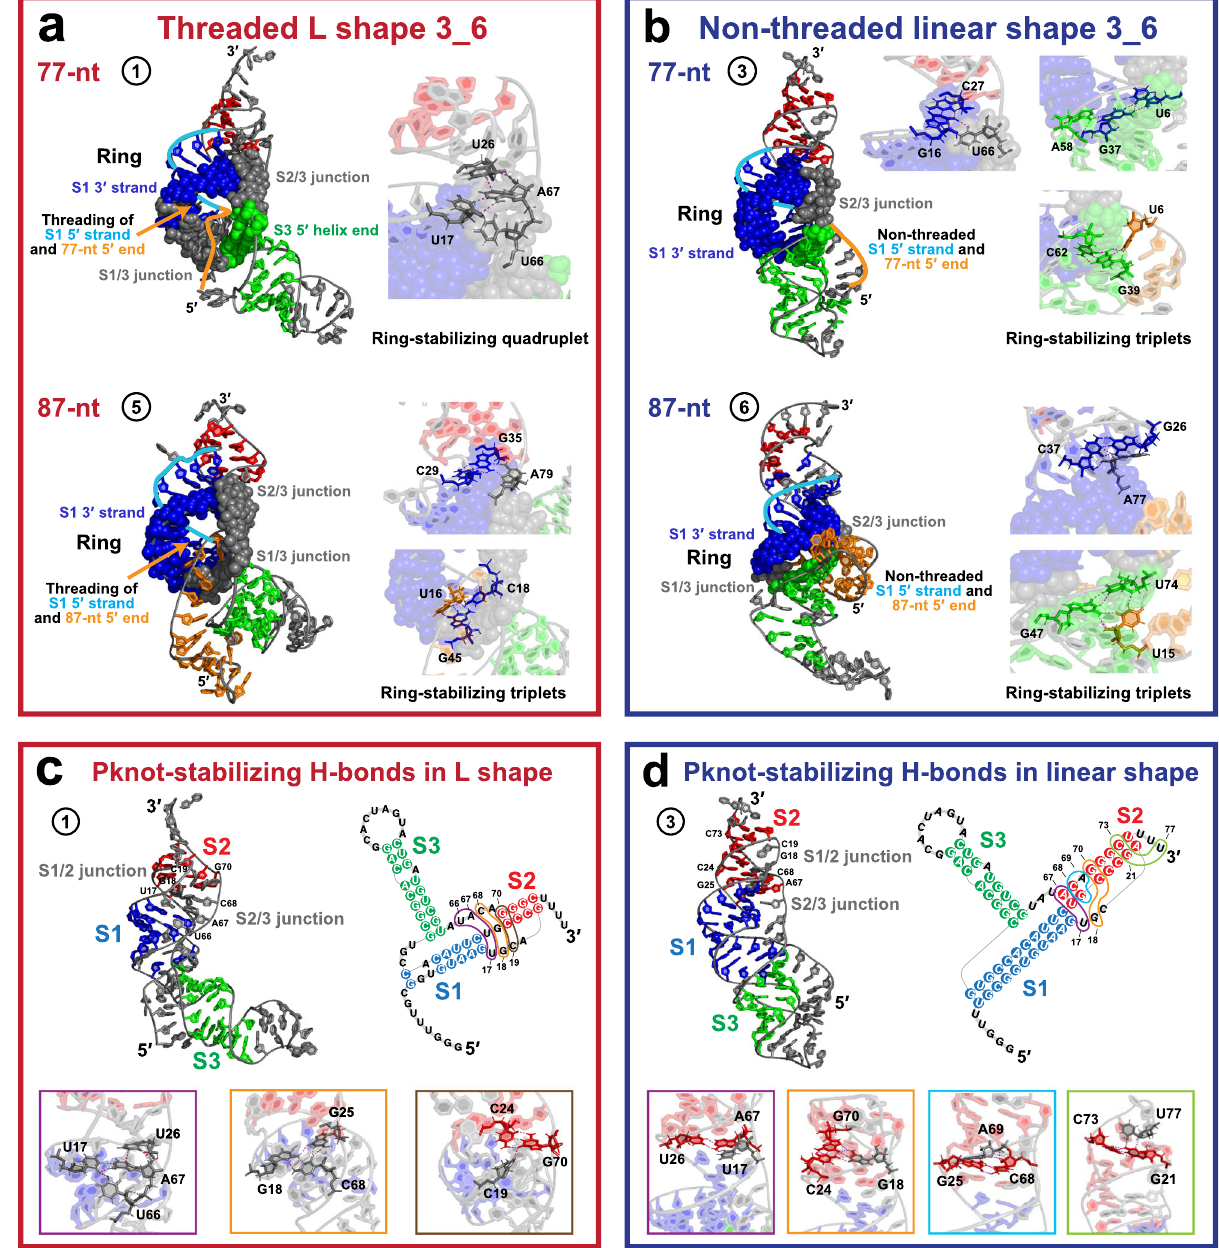
Fig. 3 Threaded L and non-threaded linear 3_6 pseudoknot ring conformations. a The threaded 3_6 models have a ring formed by the 3 0 strand of Stem 1, and the Stem 1/3 and 2/3 junctions, with the 5 0 strand of Stem 1 and the 5 0 end threaded through. Ring-stabilizing hydrogen bonds are enlarged. b The non- threaded 3_6 models with ring-stabilizing triplets. c The 77-nt L shape model has a base quadruplet and two triplets formed at the Stem 1/2 and 2/3 junctions to stabilize the pseudoknot. d The 77-nt linear shape model has four pseudoknot-stabilizing triplets formed at the junctions. The systems are numbered according to Table